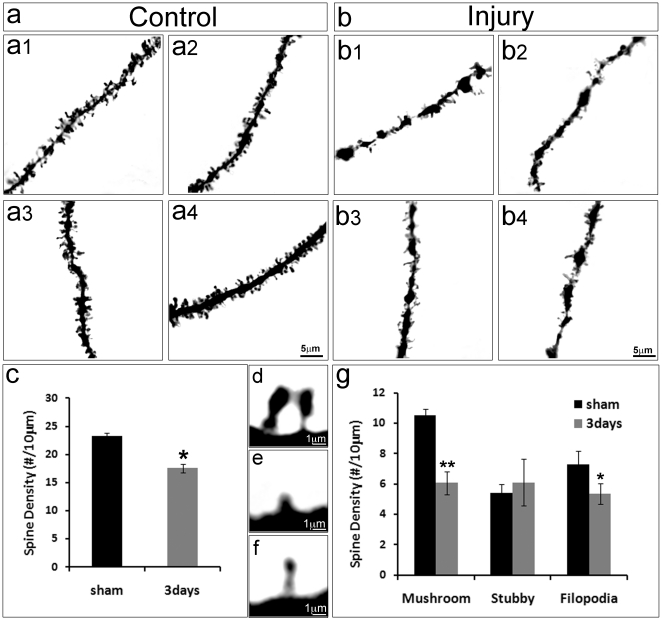
Moderate TBI leads to spine degeneration in the HDG.High power images of a single spine in control mice (a, a1–a4) and moderate TBI mice (b, b1–b4). Three types of spine, including mushroom (d), stubby (e) and fliopodia (f). Quantitative data showed that the density of the dendritic spine was significantly reduced in the spared neurons in the injured HDG (c), especially in mushroom and filopodia shaped spines (g). (n = 5, *, p<0.05, **, p<0.01).